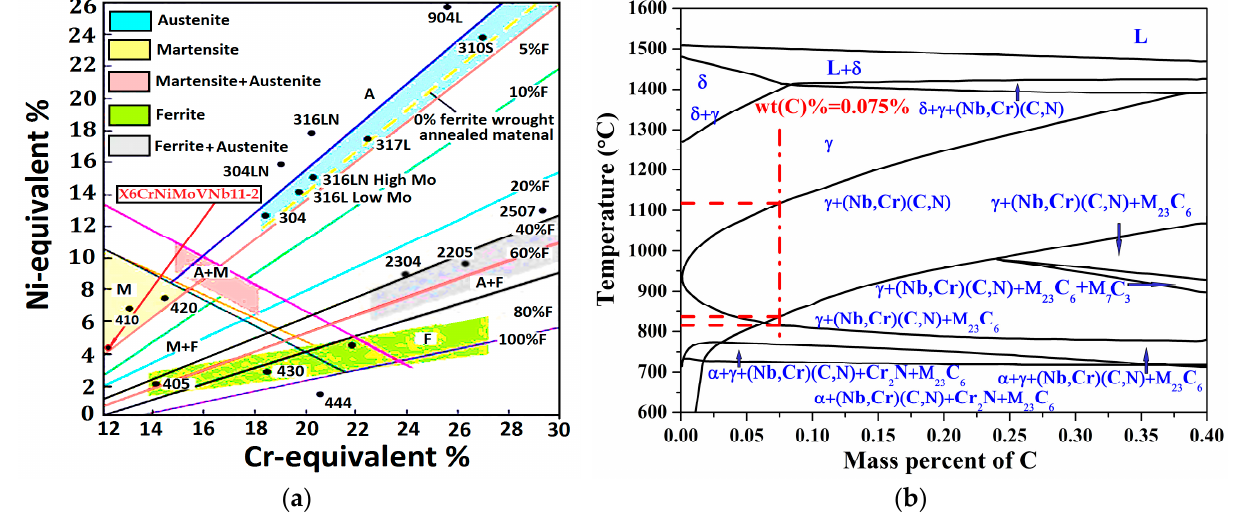
Figure 1. Schaeffler diagram and equilibrium phase diagram: ( a ) Schaeffler diagram; ( b ) equilibrium phase diagram.